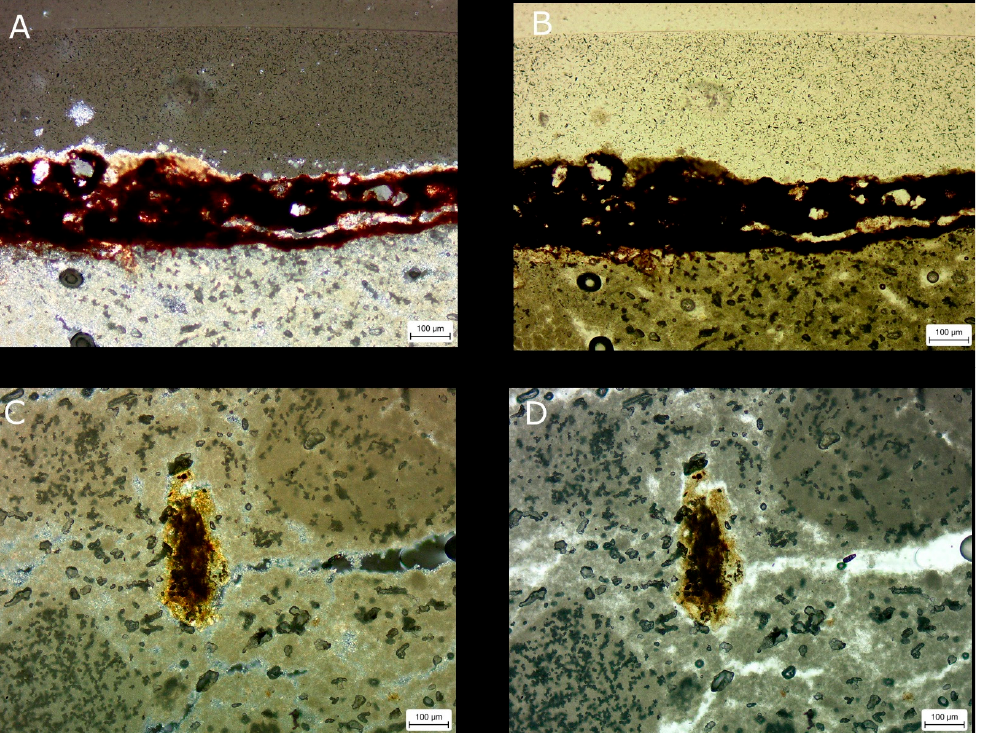
Figure 11. Photos ( A , B ) showing the layer with organic coating outside; photos ( C , D ) show micas of approximately 200 microns in size. The binder is carbonated, primarily calcite-rich and microsparite calcite, mainly associated with recrystallisations in the pore walls. Its appearance is homogeneous, with several lumps (rounded lump in Figure 10C,D). The clay content is low. Interparticle porosity in the matrix is moderate (around 25%). In addition to the microporosity associated with the lime binder, there is moldic porosity (aggregates that have been degraded or dissolved) and fracture porosity. Regarding the stratigraphy of the mortar, it is observed that it is composed of three layers at the scale of a hand sample. Photos A and B from Figure 10 show the representative texture of the first layer. The limit where this layer meets the second one is marked by the appearance of large, elongated pores parallel to the stratification. The second layer has a similar texture to the first but with a greater presence of fractures, which increase porosity (Figure 10C,D). The last and outermost layer is composed of two clearly differentiated sublayers: the first sublayer is homogeneous, reddish and quite opaque, approximately 200 microns thick on average, with small quartz aggregates (approximately 30–40 microns) and interspersed with lumps of lime; the second sublayer appears to be organic in nature and is approximately 350 microns thick on average (photos A and B from Figure 11). The chemical analysis of these layers is currently in progress. 5. Conclusions and Discussions